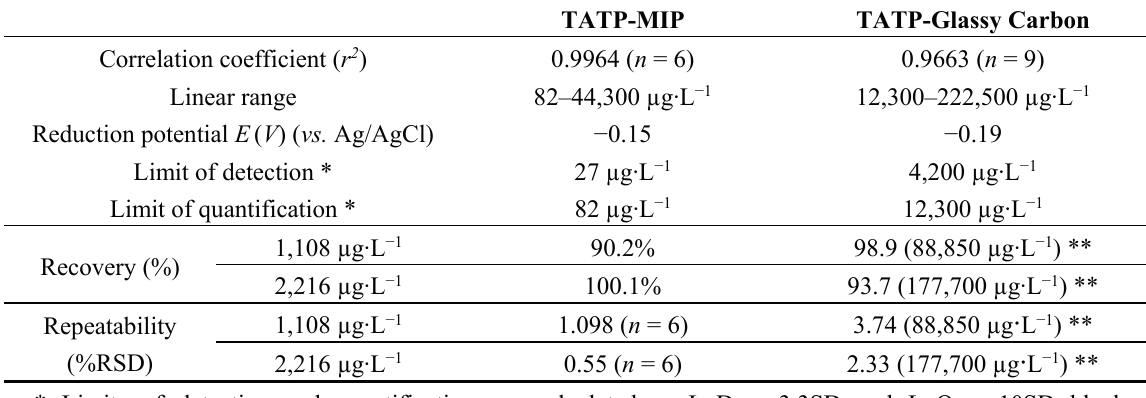
Table 1. Method validation results for the determination of TATP using a MIP electrode and glassy carbon (GC) (given in different units).